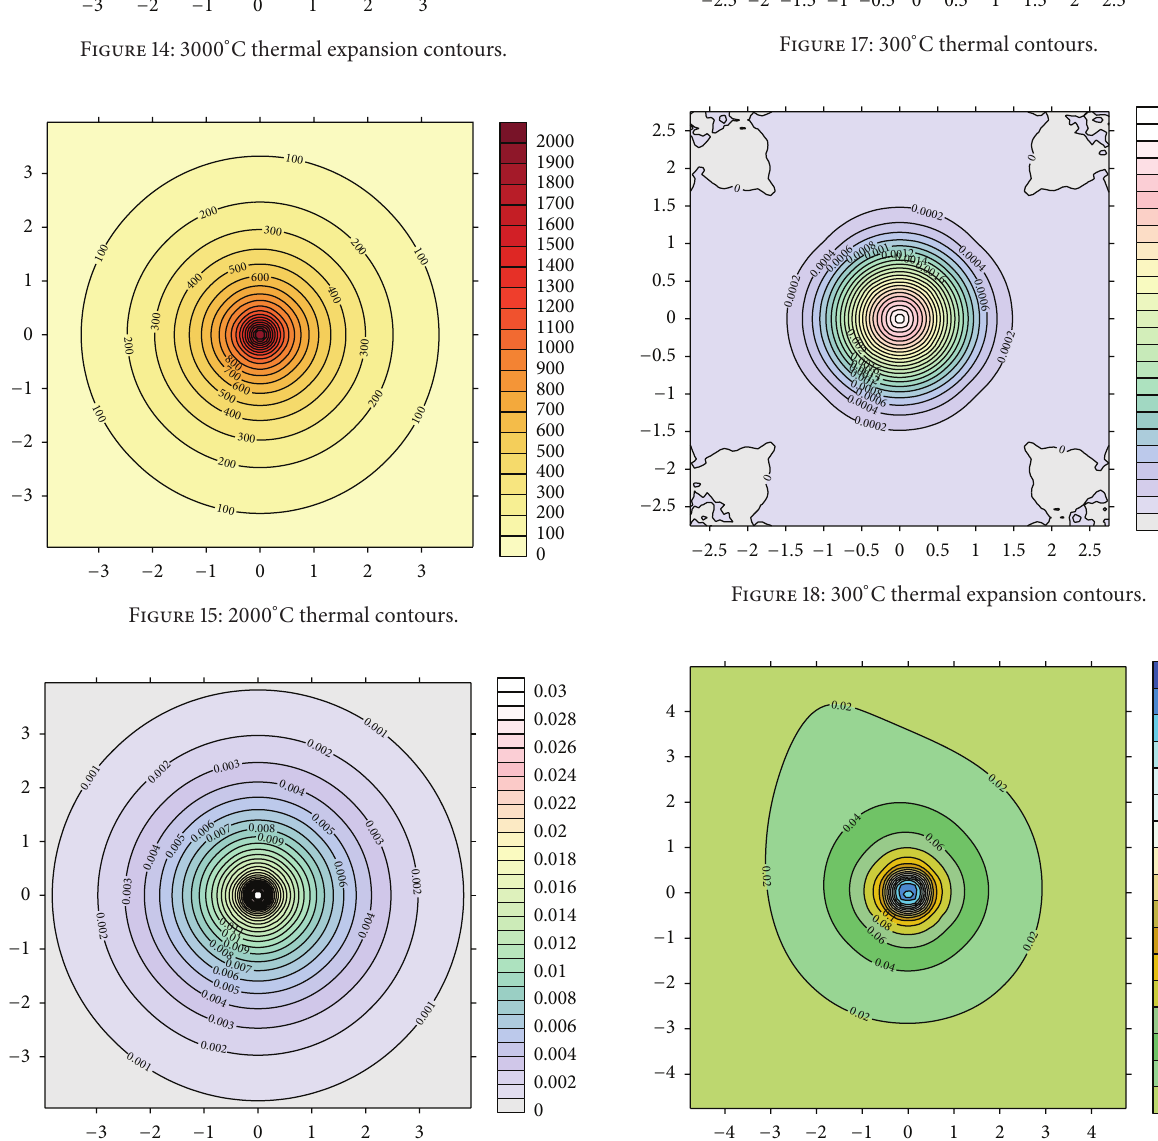
Figure 16: 2000 ∘ C thermal expansion contours.